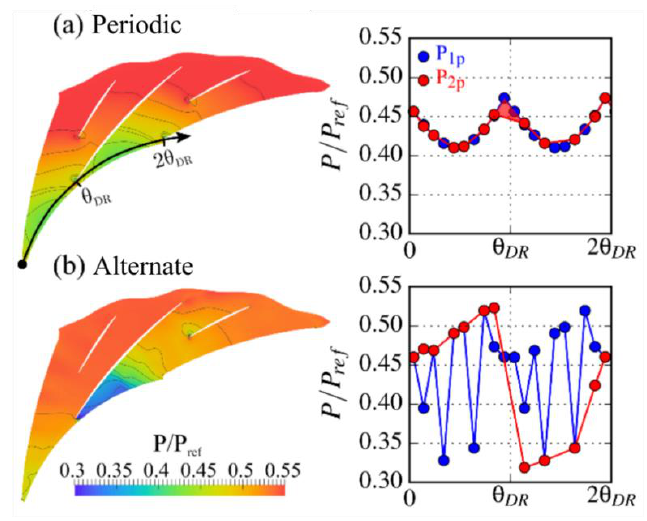
Figure 6. Numerical evaluation of the alternate rate: ( a ) Periodic case, ( b ) Alternate case.